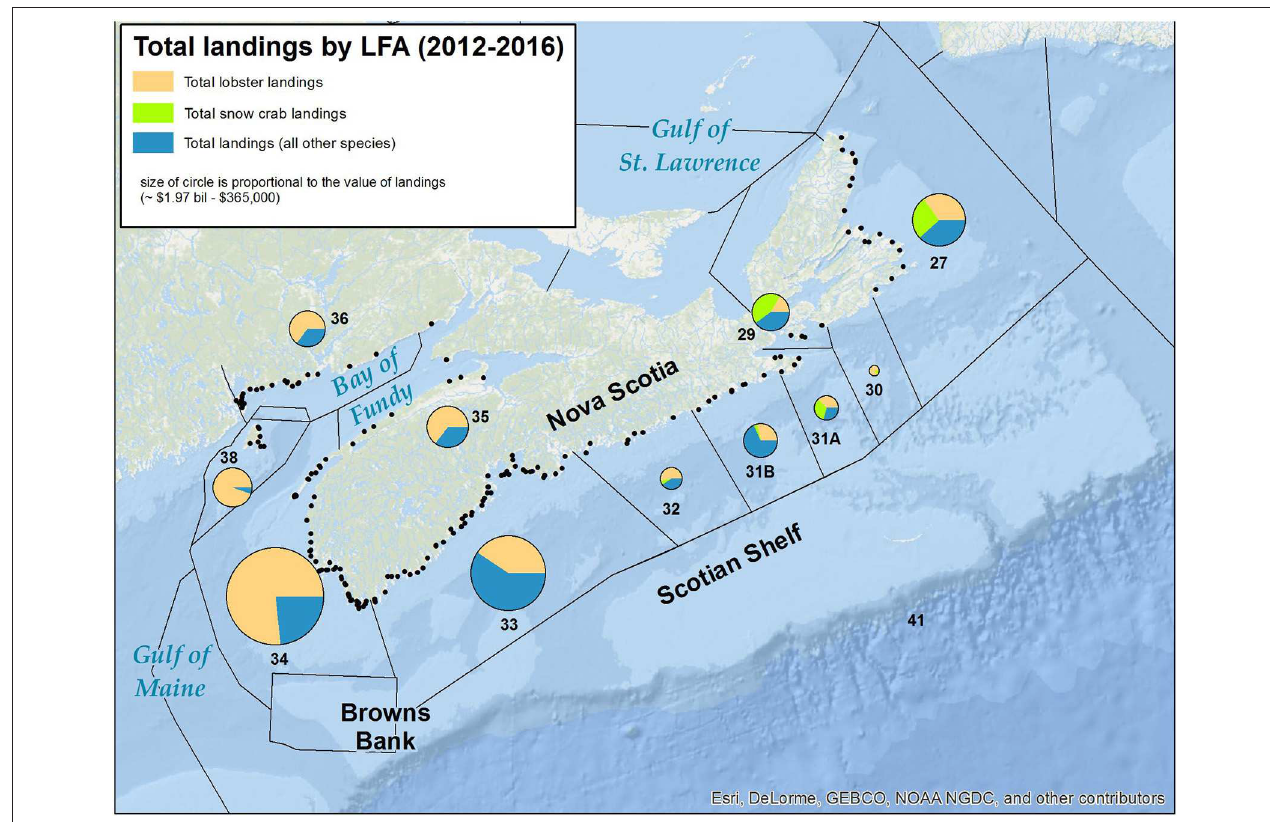
FIGURE 1 | Value of fisheries landings associated with each Lobster Fishing Area (LFA) in the Maritimes Region of Fisheries and Oceans Canada (DFO). Landings are reported at the community level, and aggregated at the level of LFA. The size of pie charts in each LFA is scaled by the total value of landings and the proportions presented for lobster, snow crab and all other species. DFO Small Craft Harbor locations are represented by the black